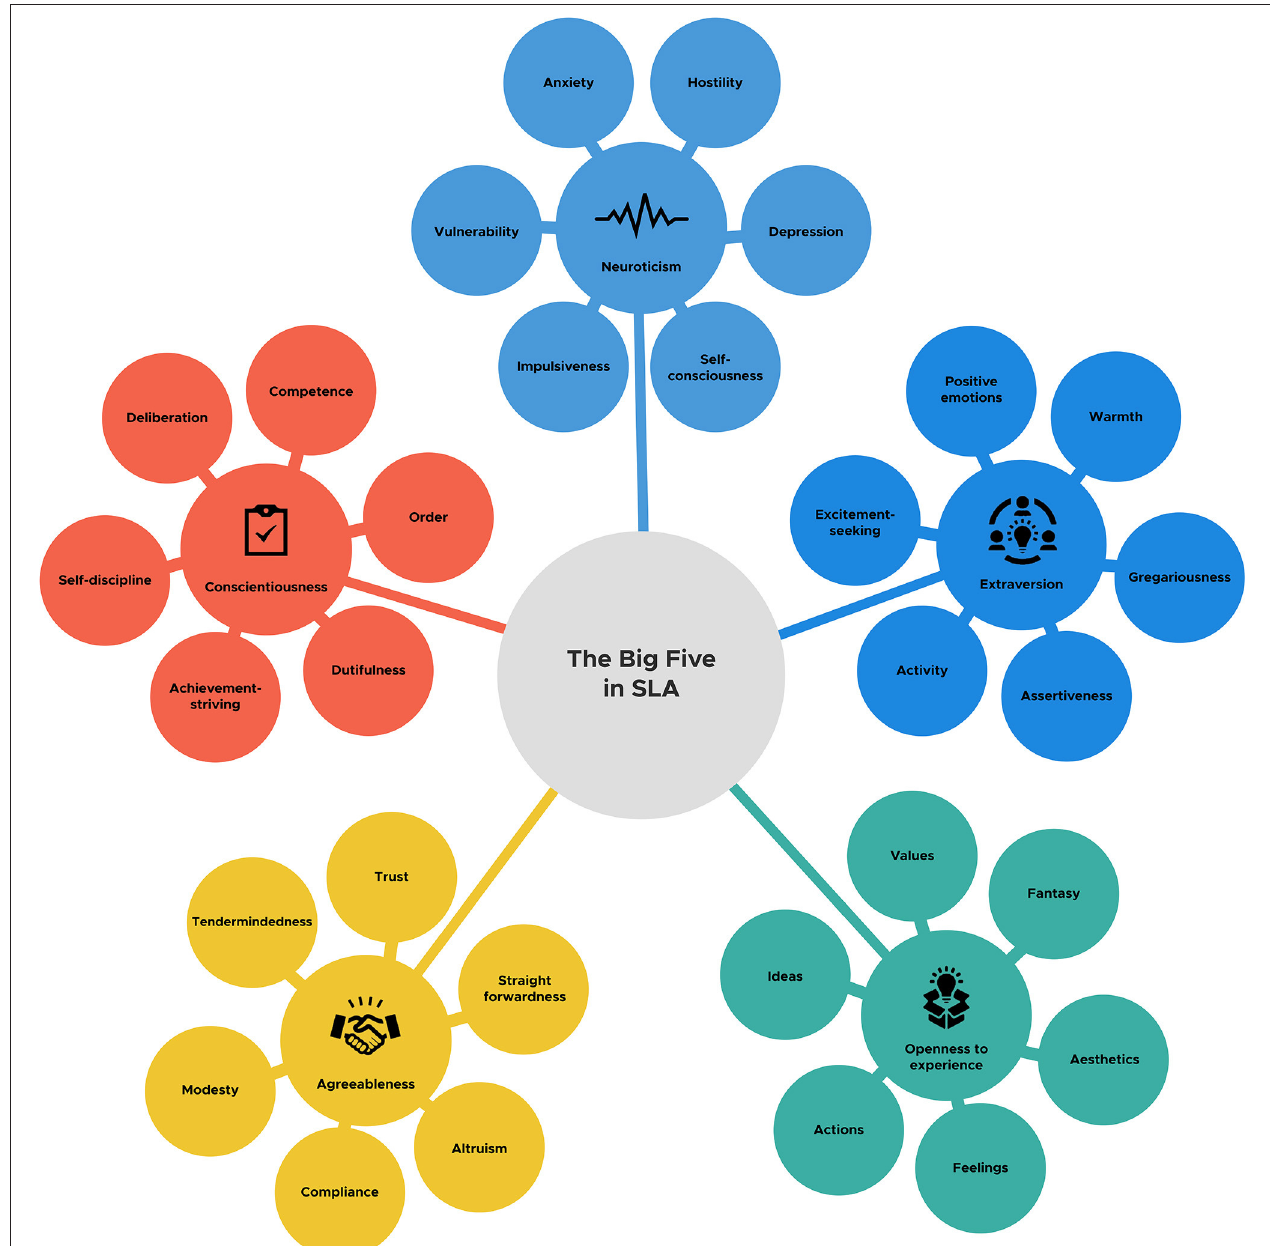
FIGURE 1 | The schematic representation of the big five model and its six